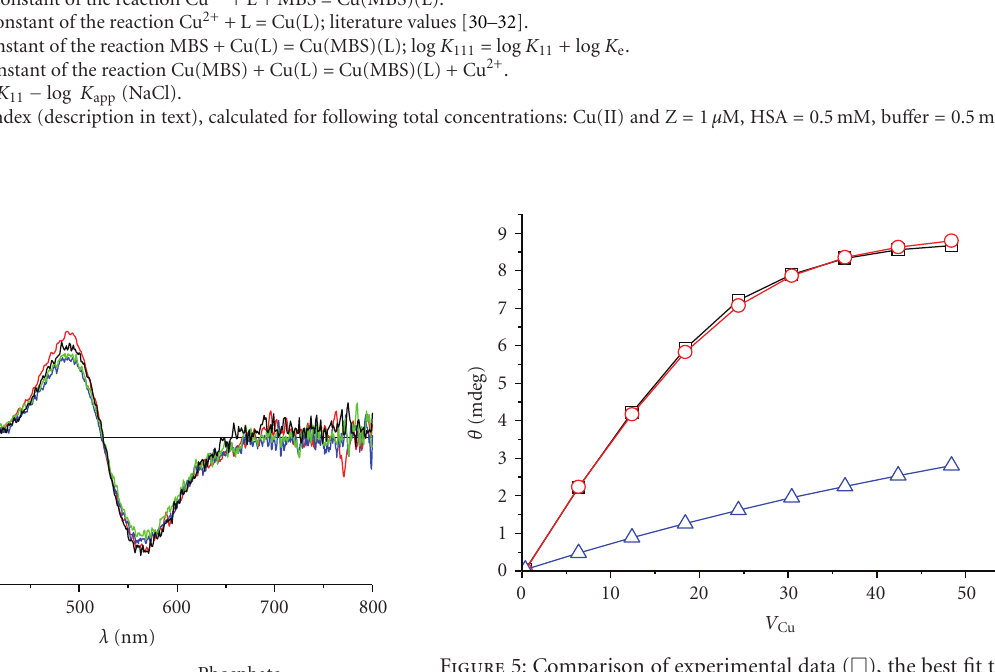
Figure 5: Comparison of experimental data ( (cid:2) ), the best fit to the ternary complex model ( ), and the simulation of titration in the absence of ternary complex formation ( ) for the titration of MBS in 0.1 M Hepes, pH